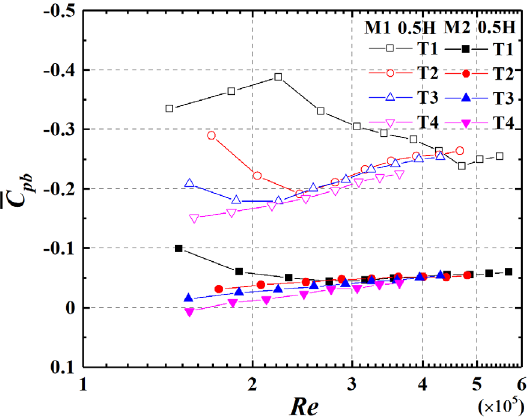
Figure 8. The variation of the base pressure coefficient with Re under different wind fields.